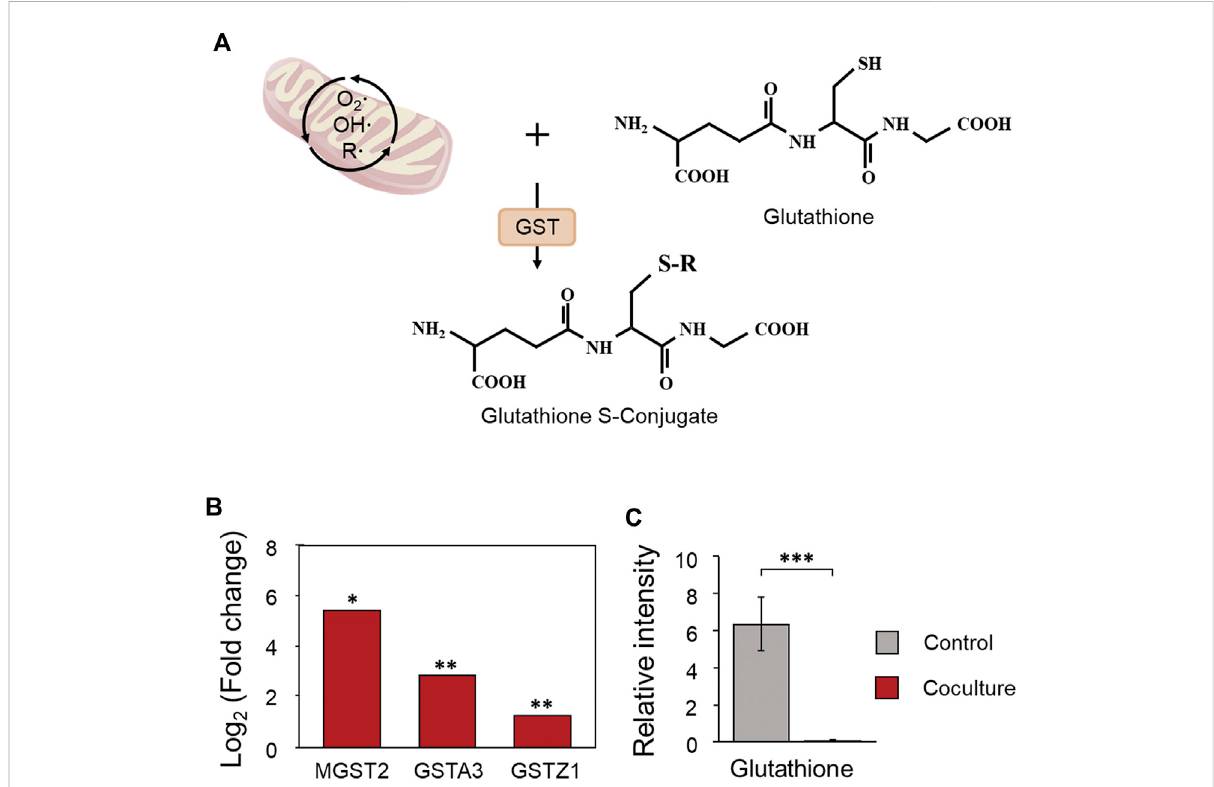
FIGURE 8 (A) The antioxidant role of glutathione S-transferase in Caco-2 cells during coculture with C. dif fi cile . (B) Proteomic changes in glutathione S-transferases in Caco-2 cells during coculture with C. dif fi cile . Proteomic analysis was performed in triplicate. (C) Comparison of theproduction of glutathione in Caco-2 cells cultured with C. dif fi cile . The error bars represent the standard deviation. Metabolomic analysis was performed in quadruplicate. GST, glutathione S-transferase; MGST2, microsomal glutathione S-transferase 2; GSTA3, glutathione S-transferase 3;